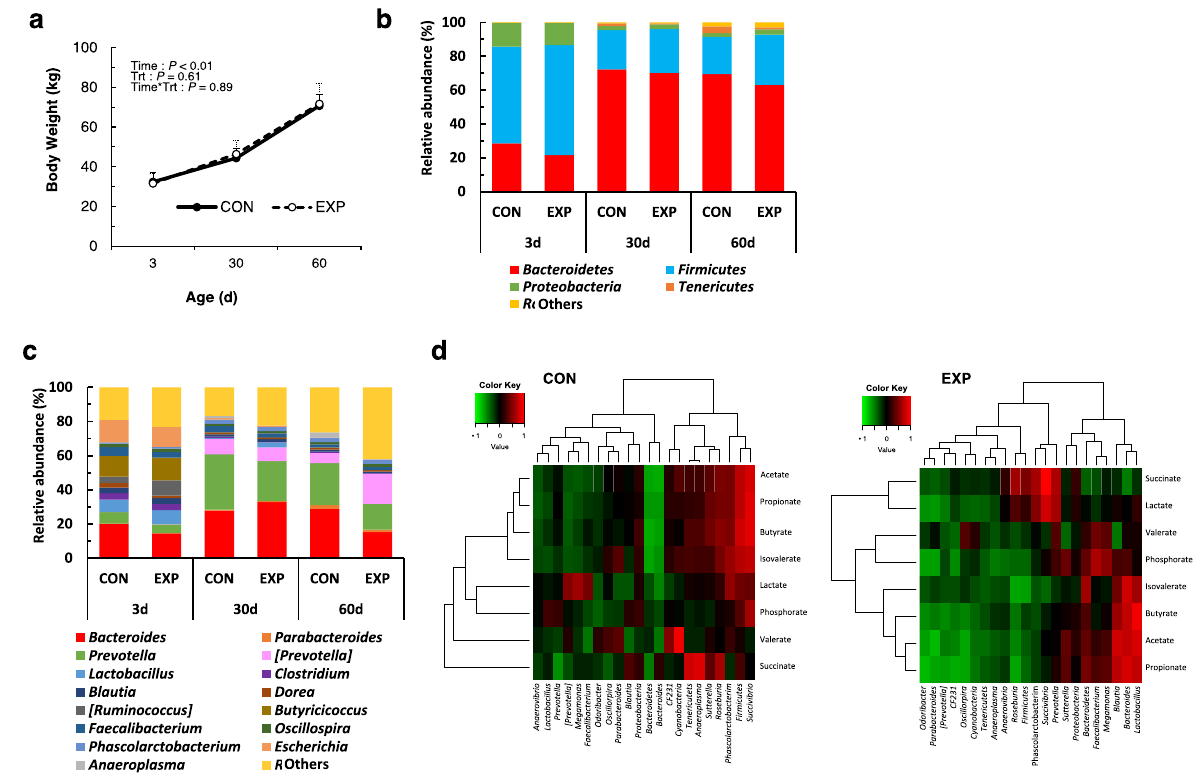
Figure 2. General statistical comparisons and correlation analyses. ( a ) Changes in BW during the period. Relative abundance of the fecal microbiota at the ( b ) phylum and ( c ) genus levels in calves fed milk replacer containing chlortetracycline (CTC) at 10 g/kg (CON) or 0 g/kg (EXP). ( d ) Correlation between fecal organic acids and bacterial genera during the period based on the sampling data at 30 and 60